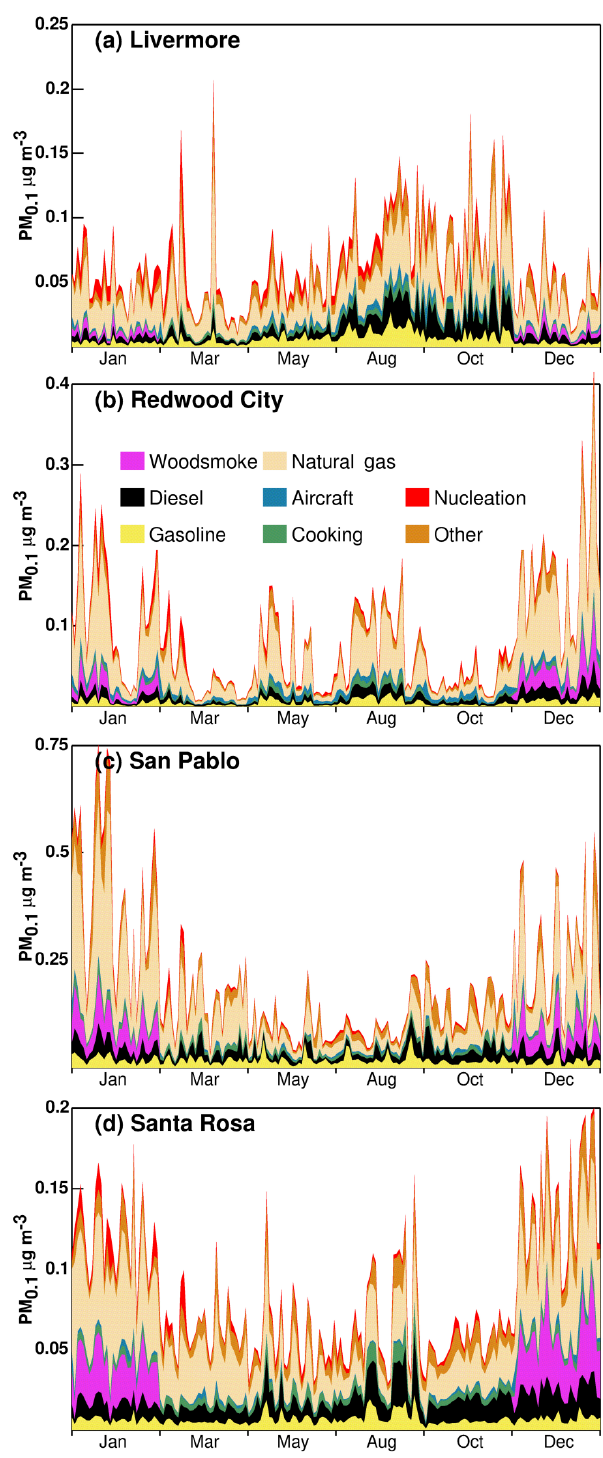
Figure 10. Seasonal variation of major source contributions to PM 0 . 1 at Livermore, Redwood City, San Pablo, and Santa Rosa, respectively. Results within each month have daily time